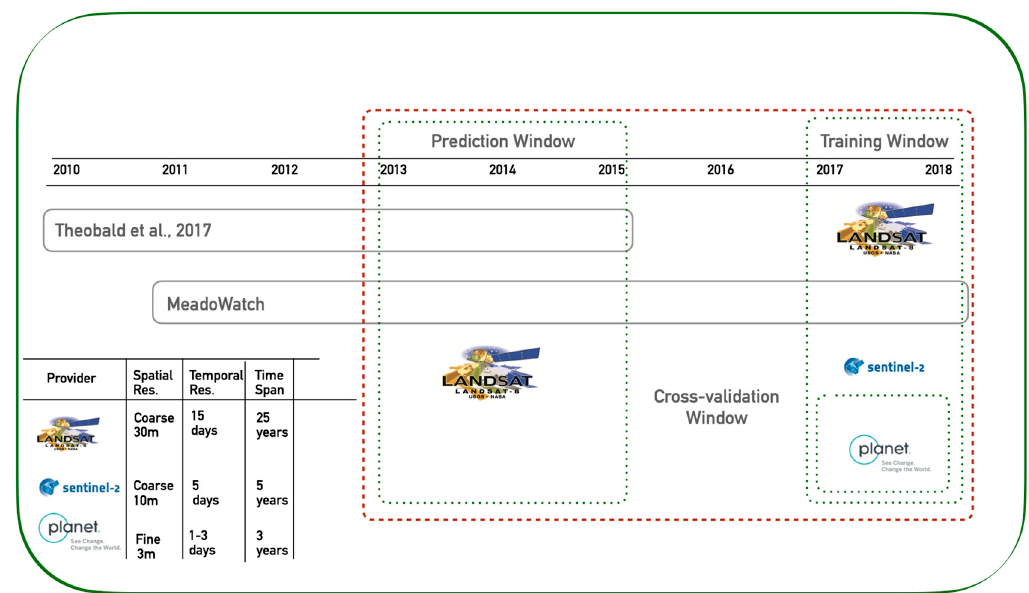
Figure A1. Time frame of fine resolution data versus coarse resolution data of the study.